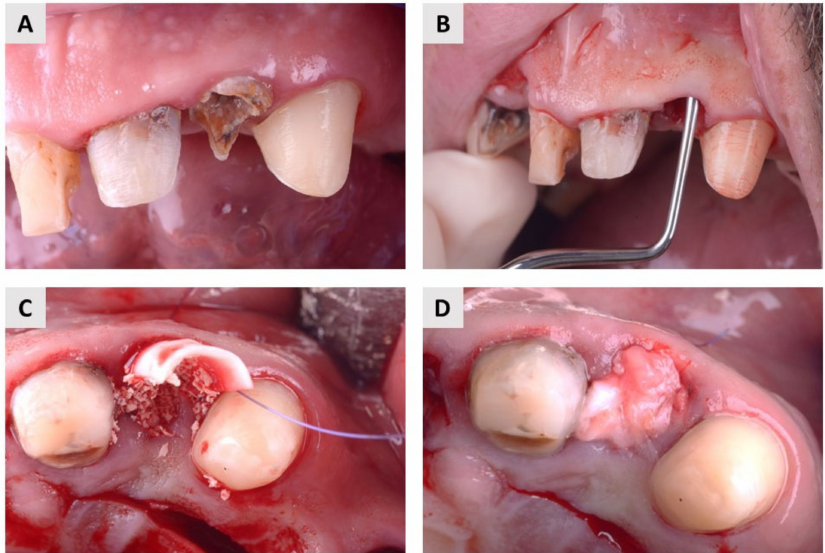
Figure 5. Surgical protocol in the control group. ( A ) A hopeless maxillary lateral incisor. ( B ) After extraction, a detailed curettage was carried out and the integrity of the alveolar bone walls was checked. ( C ) Bovine xenograft mixed with autologous bone and placed into extraction socket. A resorbable membrane was placed buccally. ( D ) Primary wound closure with connective tissue